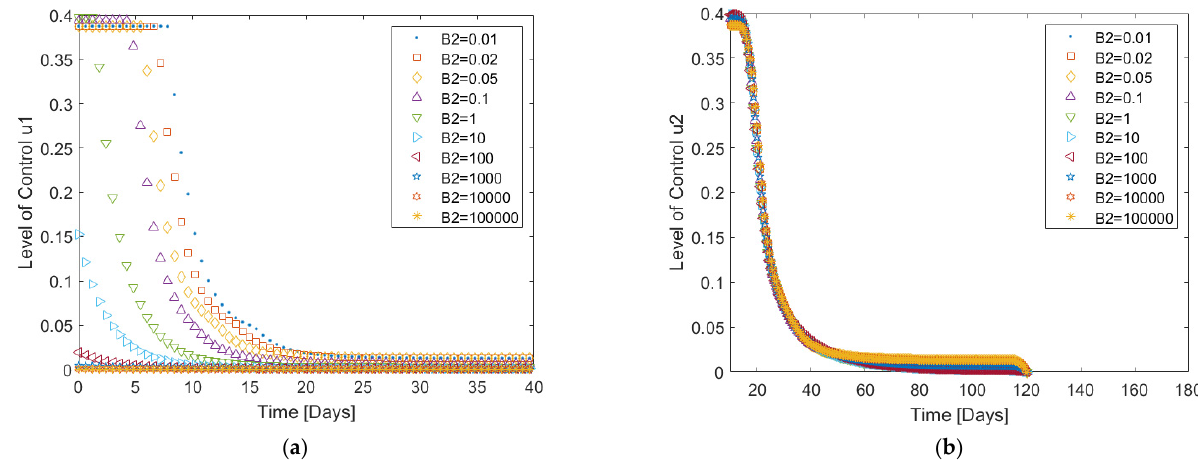
Figure 17. The t max time against parameters B 2 for the application of Policy 1 ( a ) The t max time against parameters B 2 ; Figure 17. The max t time against parameters 2 B for the application of Policy 1 ( a ) The max t time against parameters B 2 ; ( b ) the t max time against parameters B 2 , versus the fitted ( b ) the max t time against parameters B 2 , versus the fitted model.